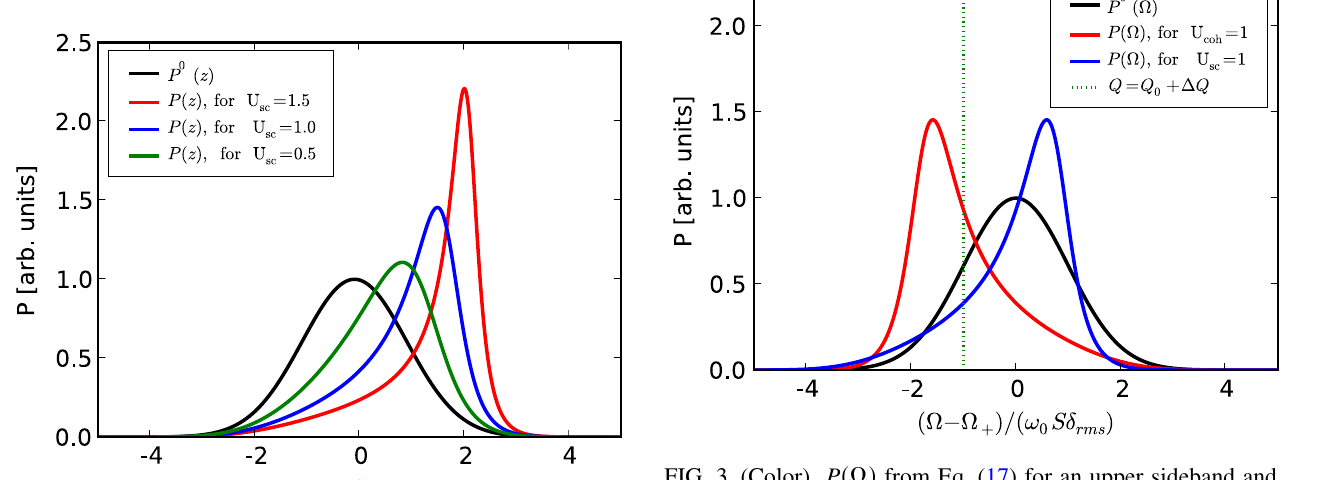
FIG. 3. (Color) P (cid:2) (cid:1) (cid:3) from Eq. (17) for an upper sideband and (cid:4) U (cid:4) 0 (black curve), U (cid:4) 1 and U (cid:4) 0 (blue for U coh sc sc coh (cid:4) 0 and U (cid:4) 1 (red curve). The dotted curve), as well as U sc coh vertical line indicates the shifted incoherent and coherent